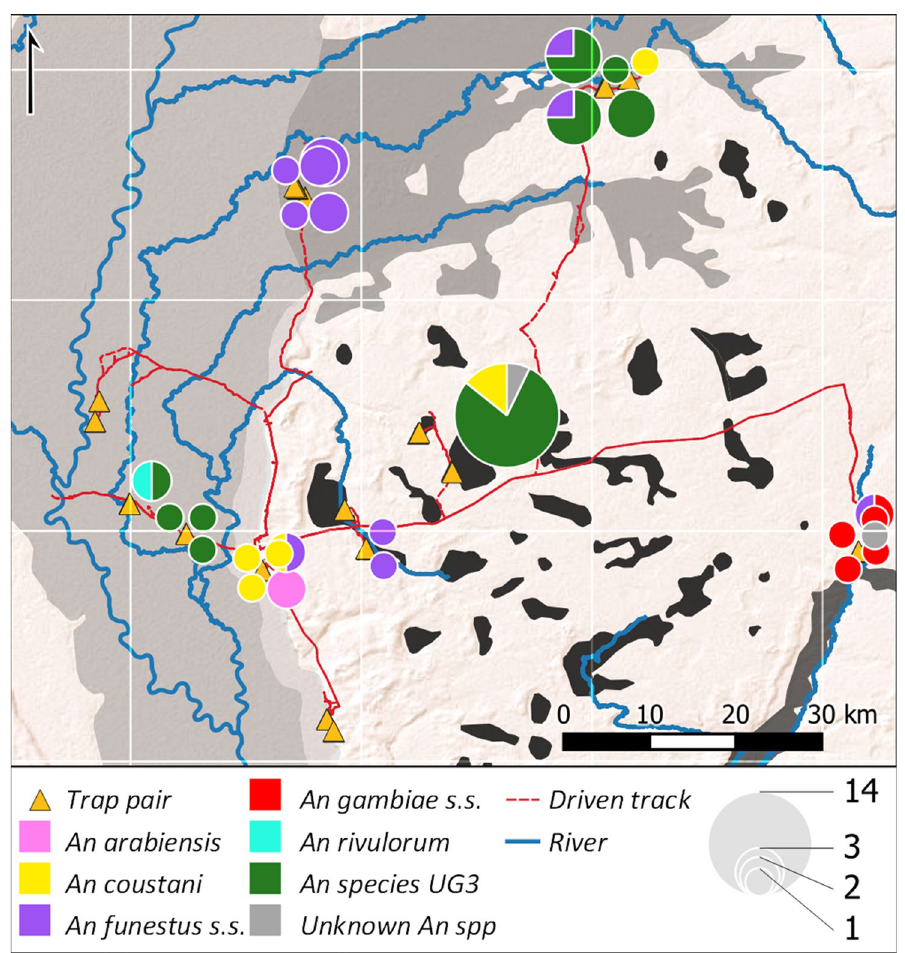
Figure 7. Distribution of adult Anopheles sampled using BGM traps in western Zambia. Specimens ( n = 54) identified from above-threshold matches of COI and/or ITS2 sequences to GenBank accessions. Pie chart area proportional to total catch per trap pair (indoor + outdoor). Ecological zones as per Fig. 1. Map drawn in QGIS 94 (v. 3.18.3-Zürich; https:// www. qgis. org); basemap: ESRI Shaded Relief